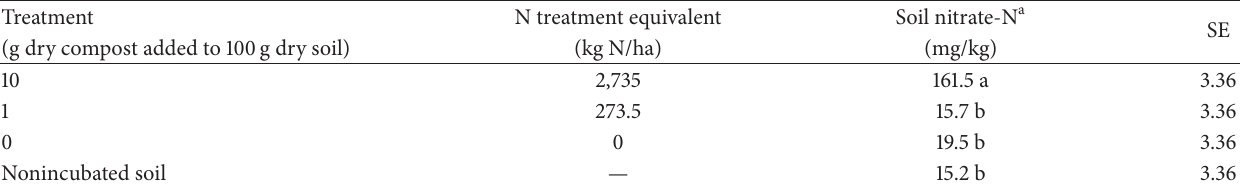
Table 5: Nitrate-N extracted from compost-amended soil, control, and nonincubated soil in a laboratory incubation study. Treatment